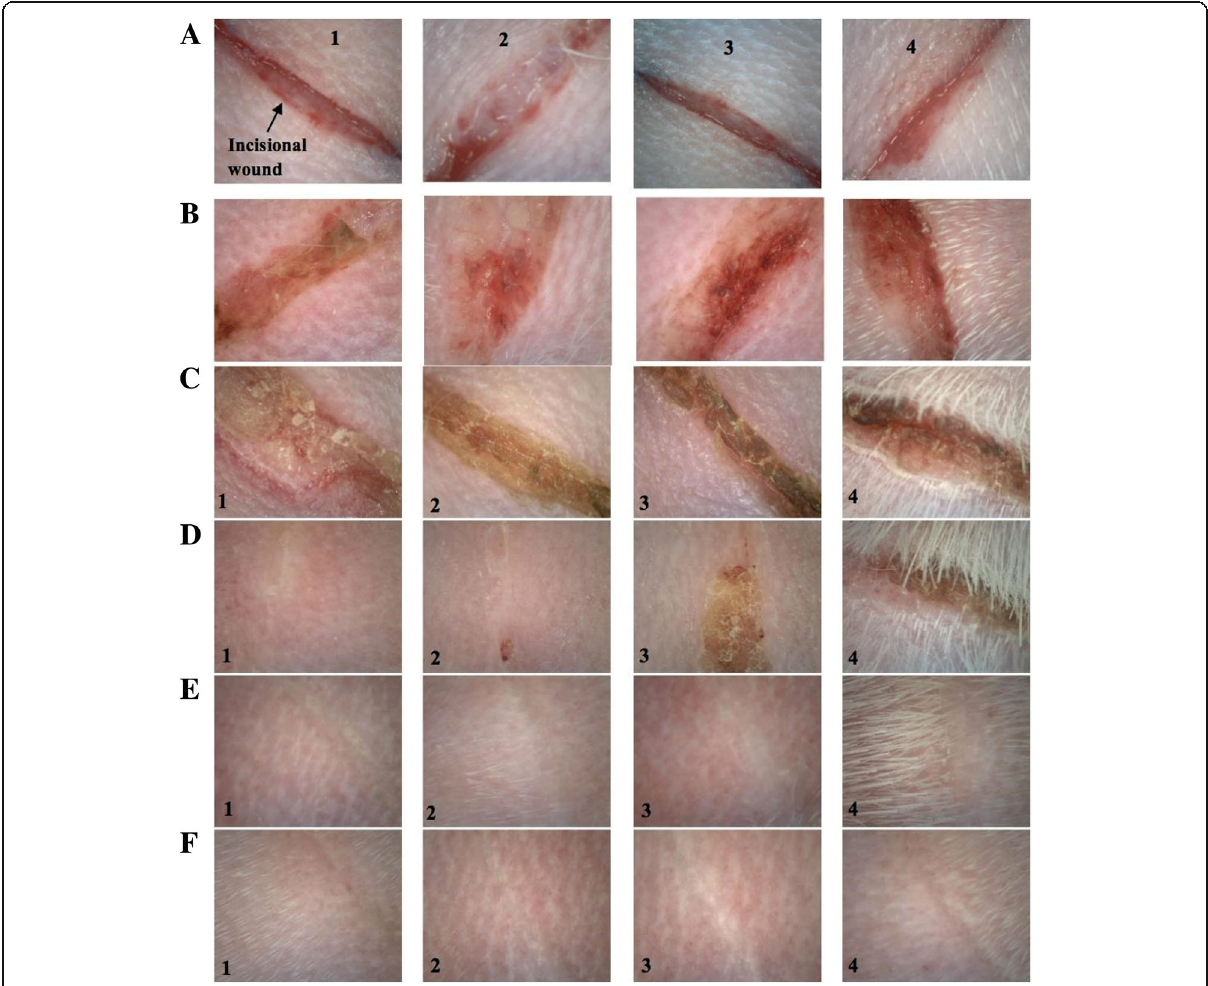
Fig. 2 Photographs of each wound treated with (1) C. asiatica hydrogel, (2) Control (Madecassol cream), (3) Blank hydrogel and (4) Control (no treatment) at ( a ) 0 days ( b ) 1 days (C) 3 days ( d ) 6 days ( e ) 9 days and ( f ) 12 days